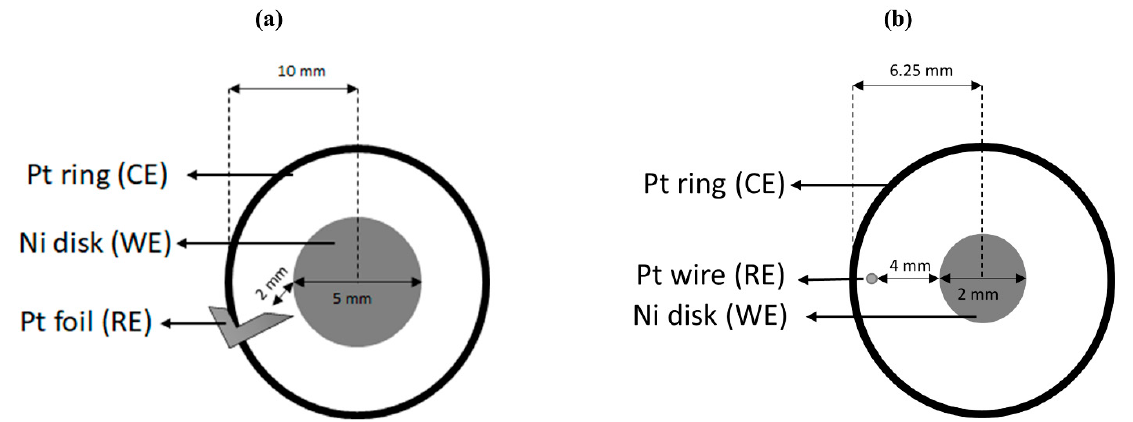
Figure 1. Schematic showing the bottom view of the electrode configuration used as the sensor probe in ( a ) RDE setup and ( b ) miniature RDE setup. The materials and distance of separation between the electrodes are shown for a better understanding of the position of electrodes.